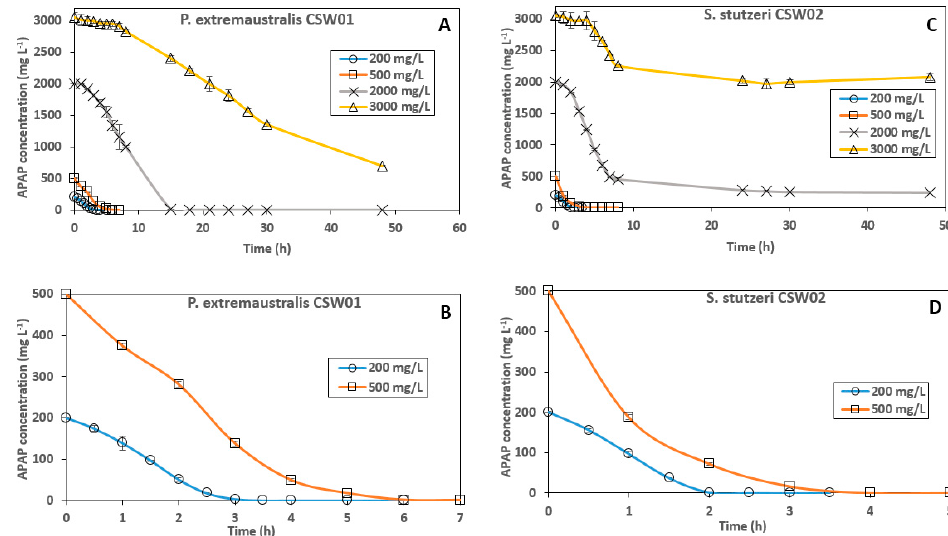
Figure 3. Influence of different initial concentrations of APAP in the degradation capacity of P. ex- tremaustralis CSW01 ( A , B ) and S. stutzeri CSW02 ( C , D ). (( B , D ) show enlarged details of ( A , C ), re- spectively).